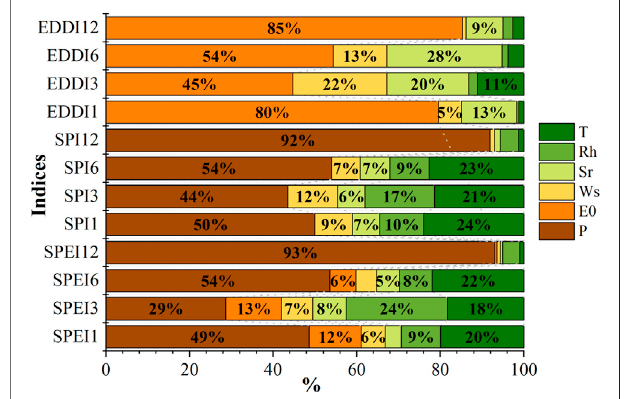
FIGURE 5 | Contribution of climate variables to drought indices are based on the RF model at 1-, 3-, 6-, 12-month timescales.